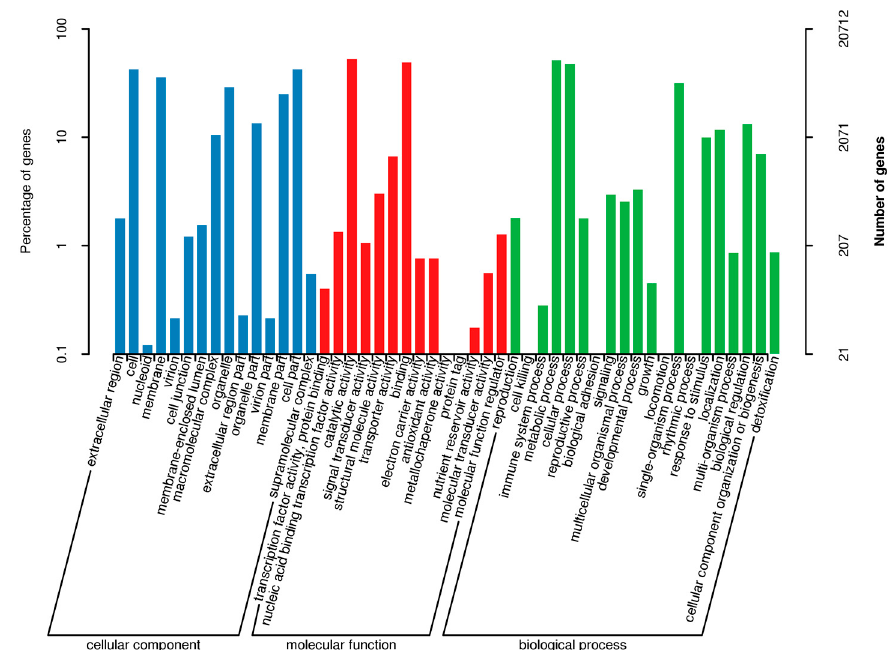
Figure 1. Gene Ontology functional annotations of avocado unigenes. The unigenes were divided into three categories (biological process, cellular component, and molecular function). A total of 19,065 unigenes were functionally characterized based on 26 Eukaryotic Orthologous Groups (KOG) categories (Figure 2). Among the 26 categories, ‘General function prediction only’ represented the largest group (5557 unigenes, 26.38%), followed by ‘Posttranslational modification, protein turnover, chaperones’ (1959 unigenes, 9.30%), and ‘Signal transduction mechanisms’ (1729 unigenes, 8.19%). ‘Extracellular structures’ and ‘Cell motility’ were the two smallest groups. Additionally, 12,638 unigenes were assigned to 130 pathways in the Kyoto Encyclopedia of Genes and Genomes (KEGG) database (Table S4), with carbon metabolism (571 unigenes), biosynthesis of amino acids (516 unigenes), and ribosome (465 unigenes) representing the three most common pathways.